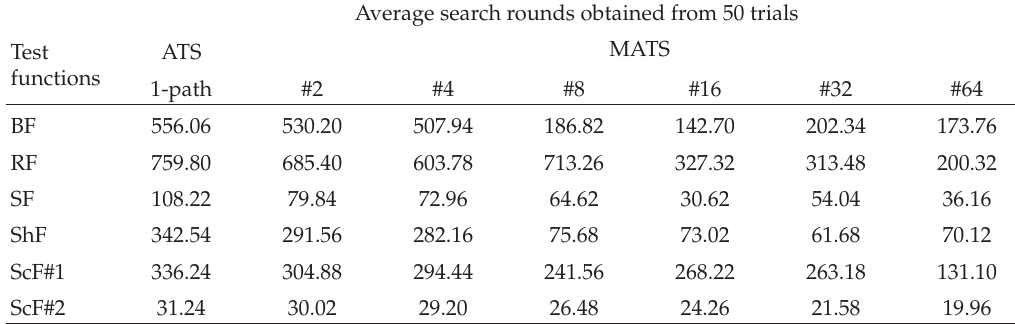
Table 6: Average values of search rounds.